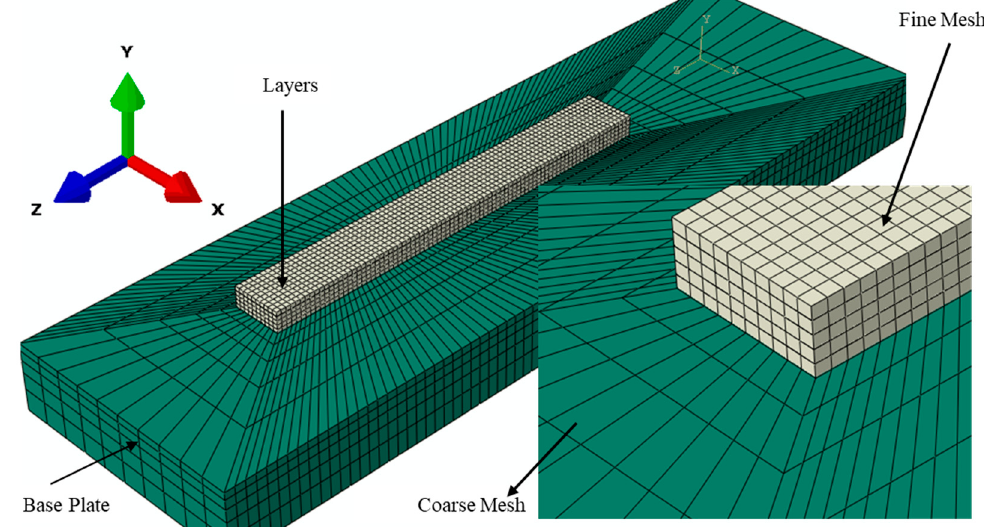
Figure 5. Meshed FE model.